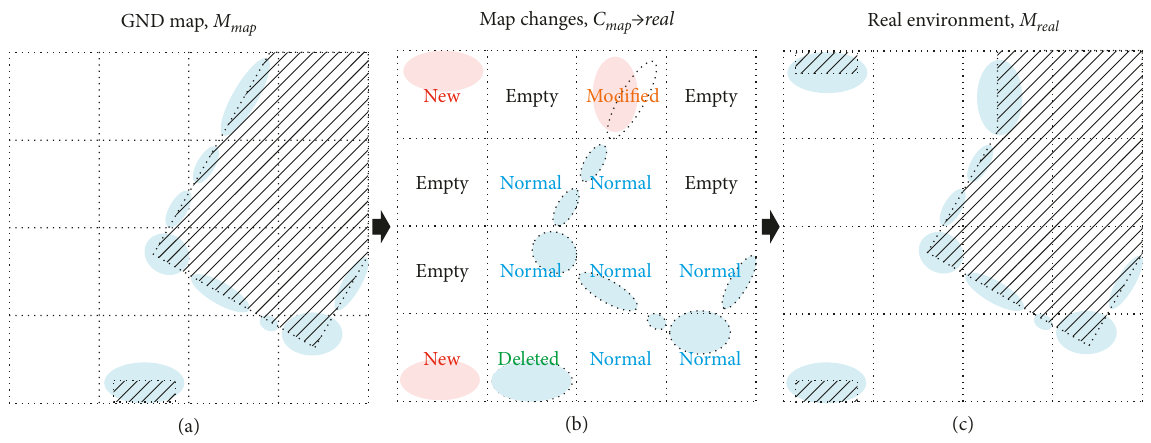
Figure 3: Definition of five map change classes including normal , empty , new , deleted , and modified . GND map, M map